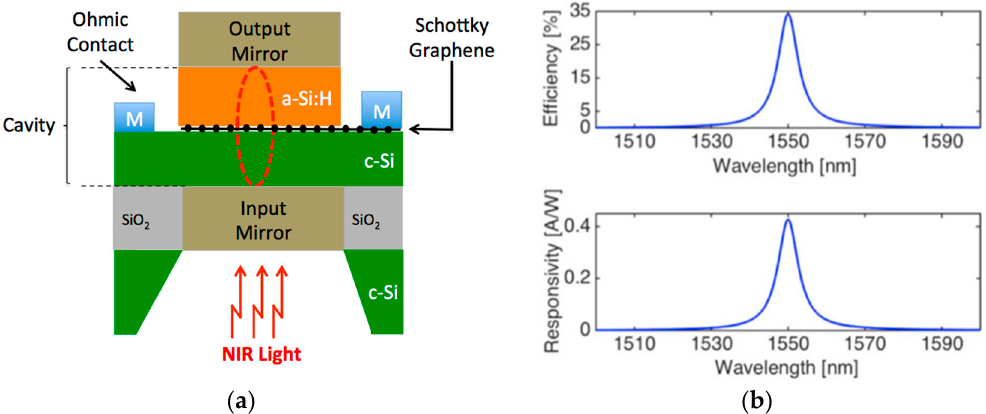
Figure 7. ( a ) Section sketch and ( b ) theoretical responsivity and quantum efficiency of the high-finesse resonant cavity enhanced PD investigated in Casalino [39]. Reprinted with permission from (Casalino. Design of Resonant Cavity-Enhanced Schottky Graphene/Silicon Photodetectors at 1550 nm. J. Ligthwave Technol. 2018 , 36 , 1766–1774). Copyright (2018) IEEE.